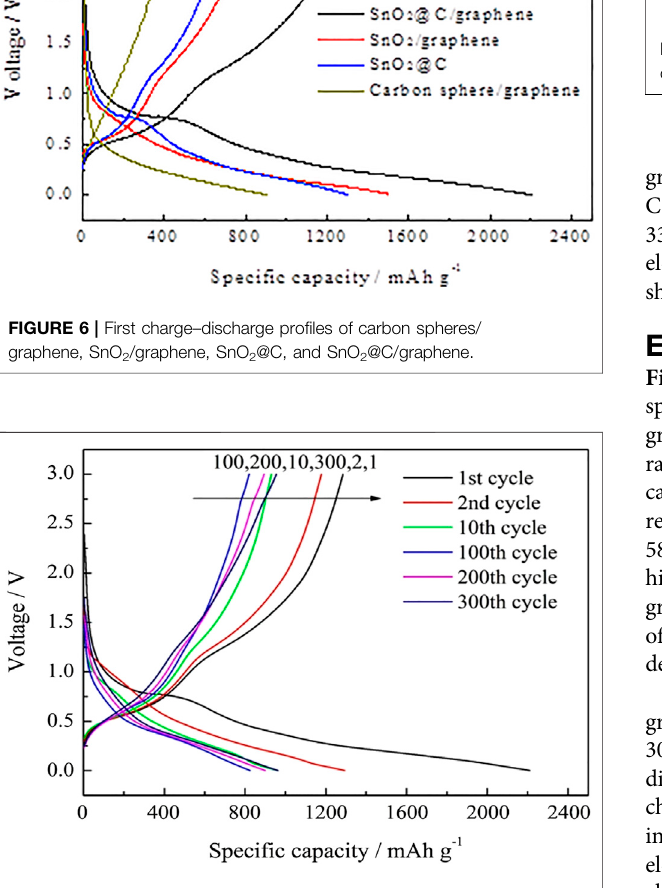
FIGURE 7 | Charge – discharge pro fi les of SnO 2 @C/graphene cycled for the 1st, 2nd, 10th, 100th, 200th, and 300th cycle at a current density of 1,000 mA g − 1 .